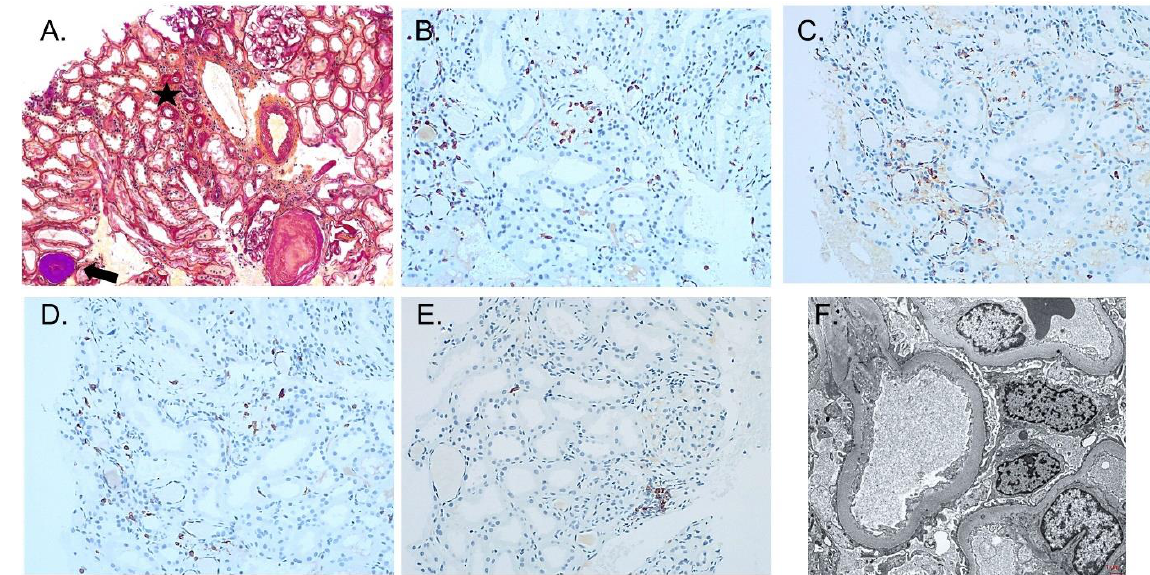
Figure A2. Kidney biopsy. Renal biopsy tissue was fixed in paraffin and sections were stained with hematoxylin and eosin. Immunophenotyping was performed by immunostaining (CD3, CD4, CD8, CD20).